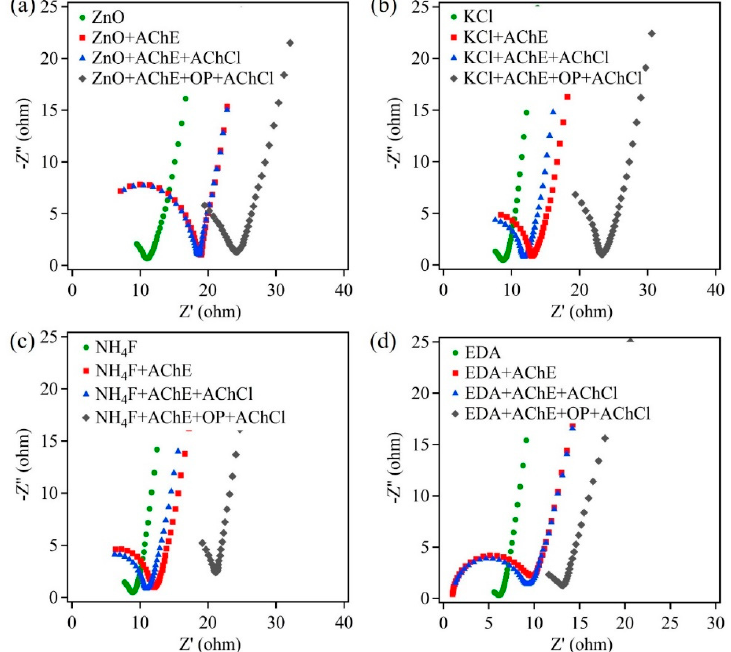
Figure 7. The Nyquist plot of ZnO samples on carbon cloth: ( a ) ZnO, ( b ) ZnO + KCl, ( c ) ZnO + NH ₄ F, and ( d ) ZnO + EDA. Table 2. Rct values obtained from EIS measurements for ZnO samples on carbon cloth.